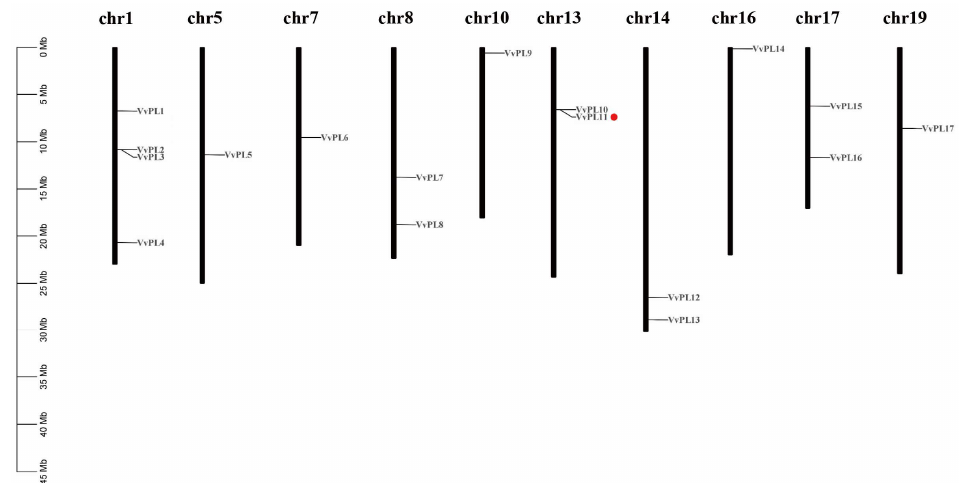
Figure 1. Chromosome distribution of pectin lyase (PL) genes in the grapevine genome. Chromosome numbers are shown at the top of each chromosome. Scale is in megabases (Mb).